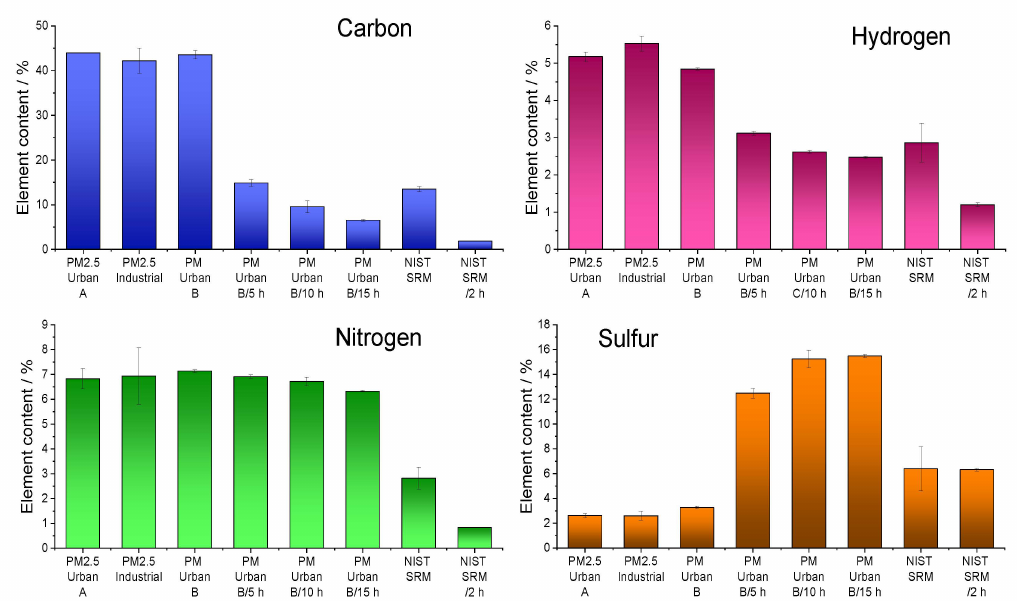
Figure 2. Comparison of the C, H, N, and S elemental content in NIST SRM 1648a, particulate matter collected in Krak ó w, and plasma-treated